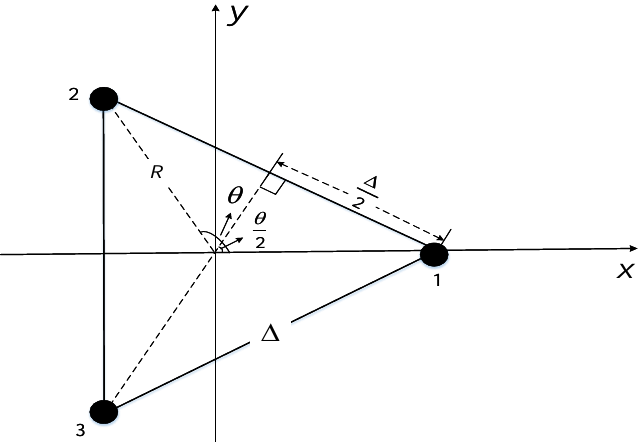
Figure 3. The optimal trajectory of UAVs in the scenario of K = 1 and M =